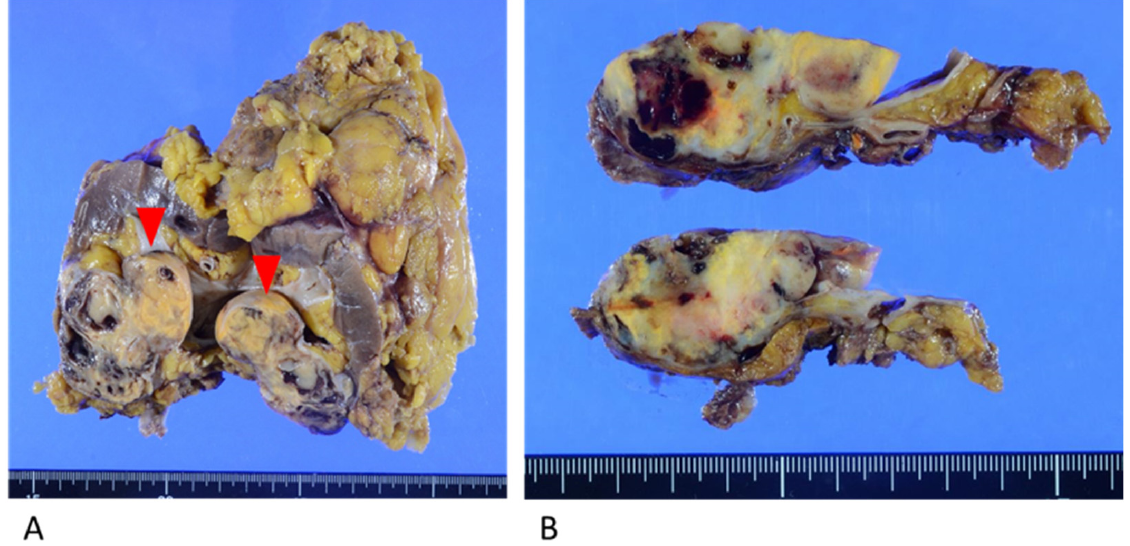
Figure 3. Resected kidney specimen. ( A ) Yellowish mass in the lower pole of the kidney, protruding toward the renal pelvis (red arrows). ( B ) The mass invaded the fat of the renal sinus and the renal parenchyma.